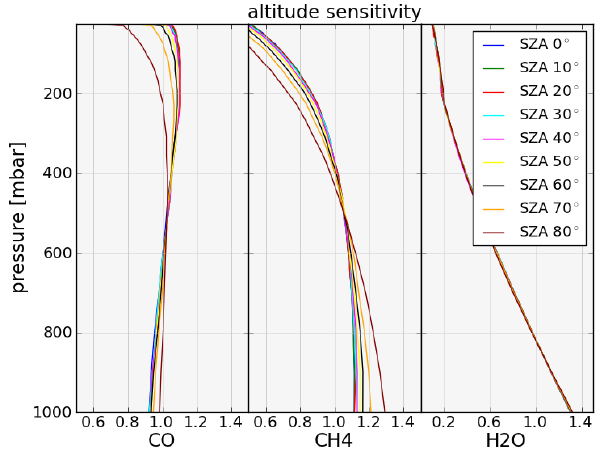
Fig. 2. Altitude sensitivity of CO (left), CH 4 (mid), and H 2 O in channel 8.